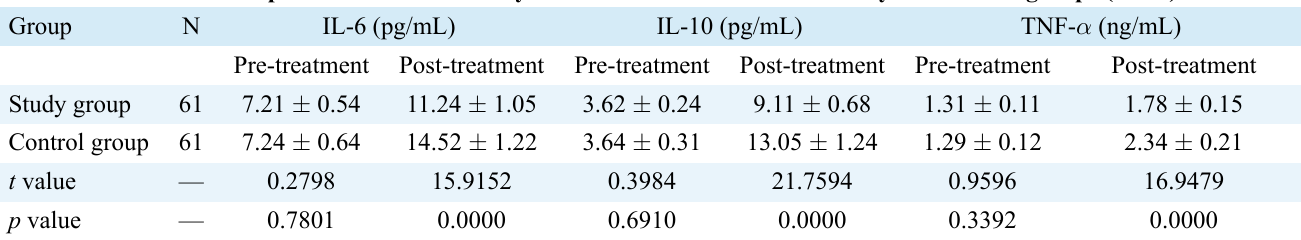
TABLE 1. Comparison of inflammatory reaction indicators between study and control groups ( ¯ x ± s ).